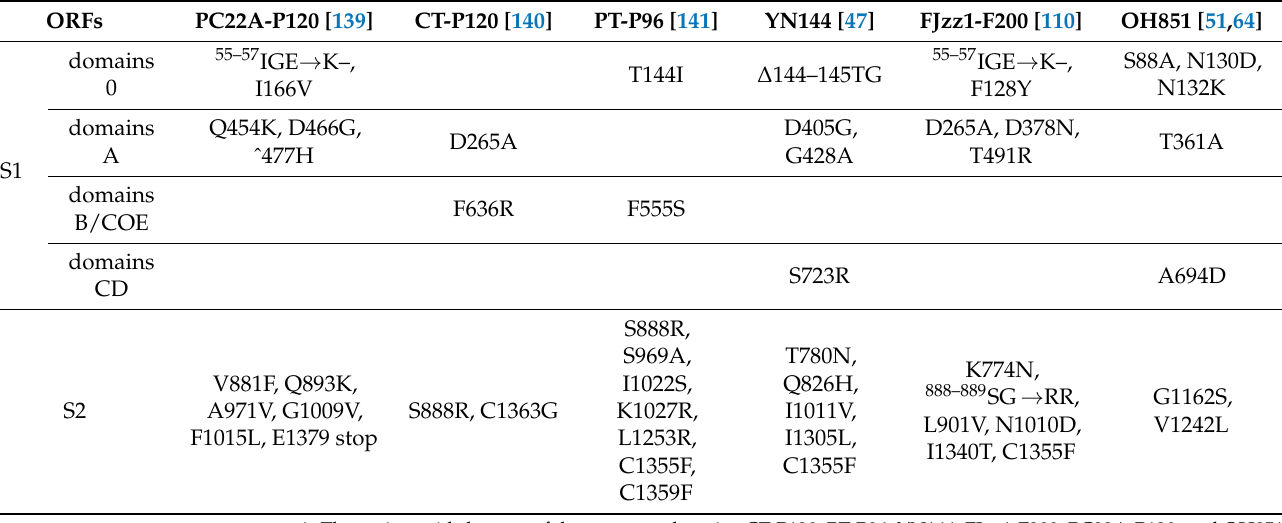
Table 3. Amino acid changes on the S protein of PEDV attenuated